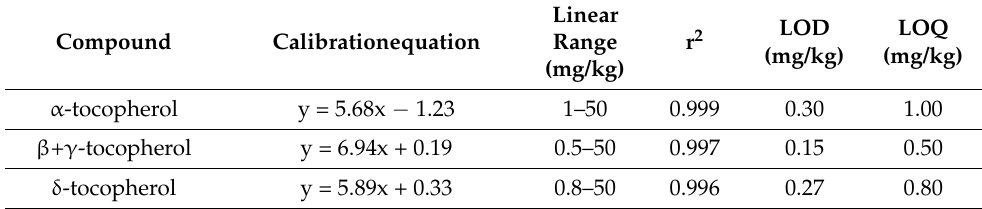
Table 1. HPLC-UV analytical parameters.